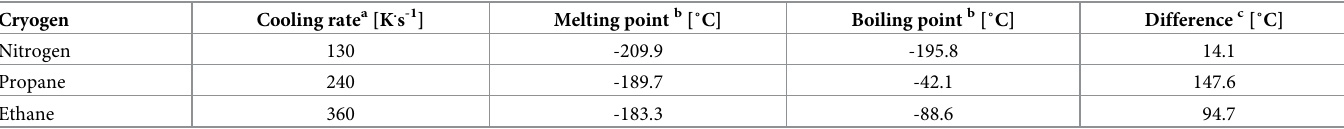
Table 1. Physical properties of nitrogen, propane and ethane under standard